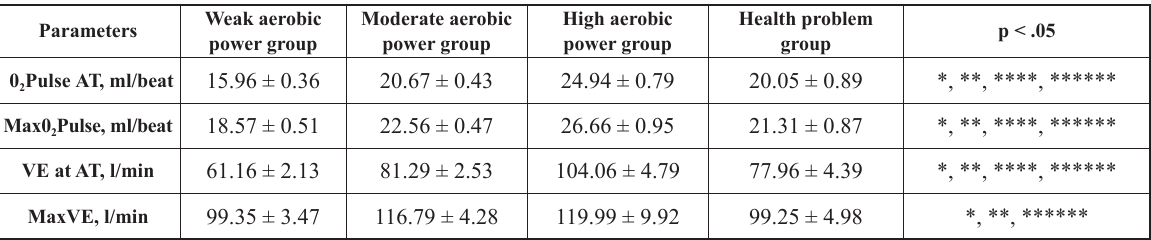
Table 3. Spirometric parameter values at the anaerobic threshold during bicycle ergometry Parameters